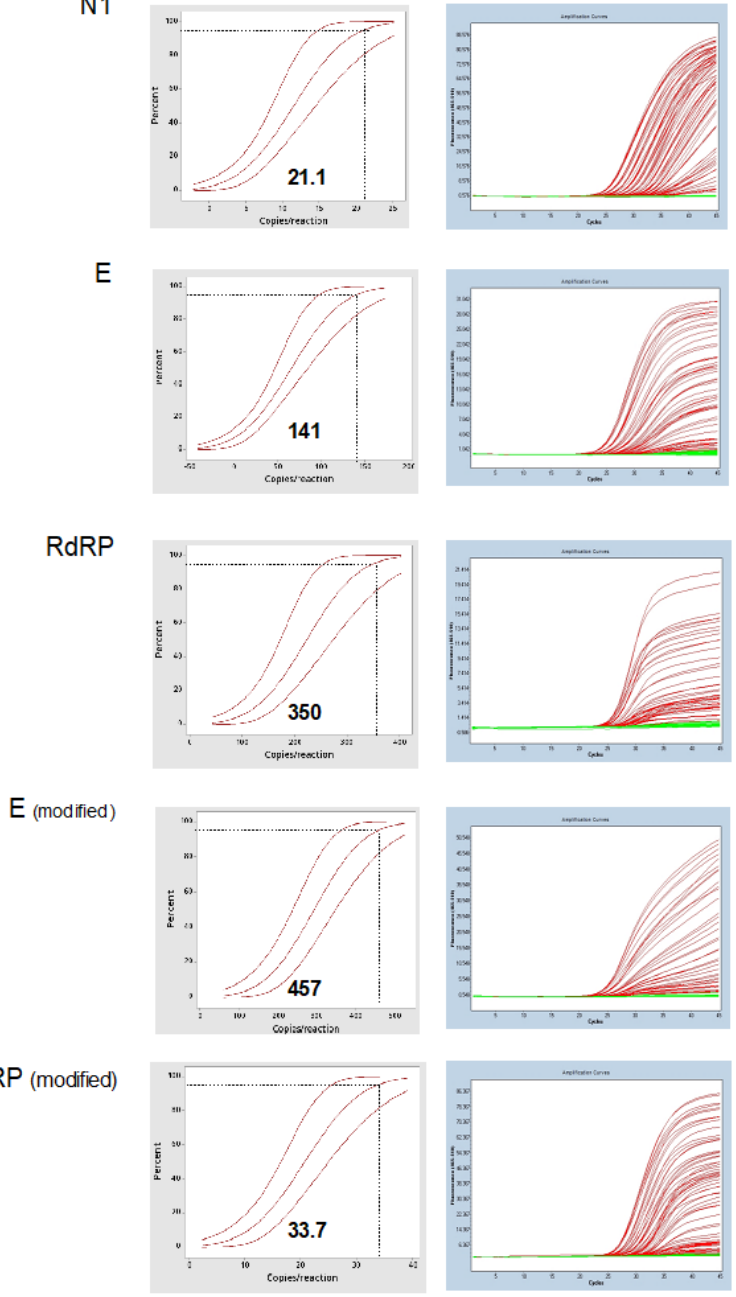
Figure 4. Determination of assays′ limit of detection. Left panel—probit regression analysis (inserted values unit are copies/reaction); right panel—raw data. N1 and RdRP (modified) showed better LOD, followed by E, RdRP, and E (modified).